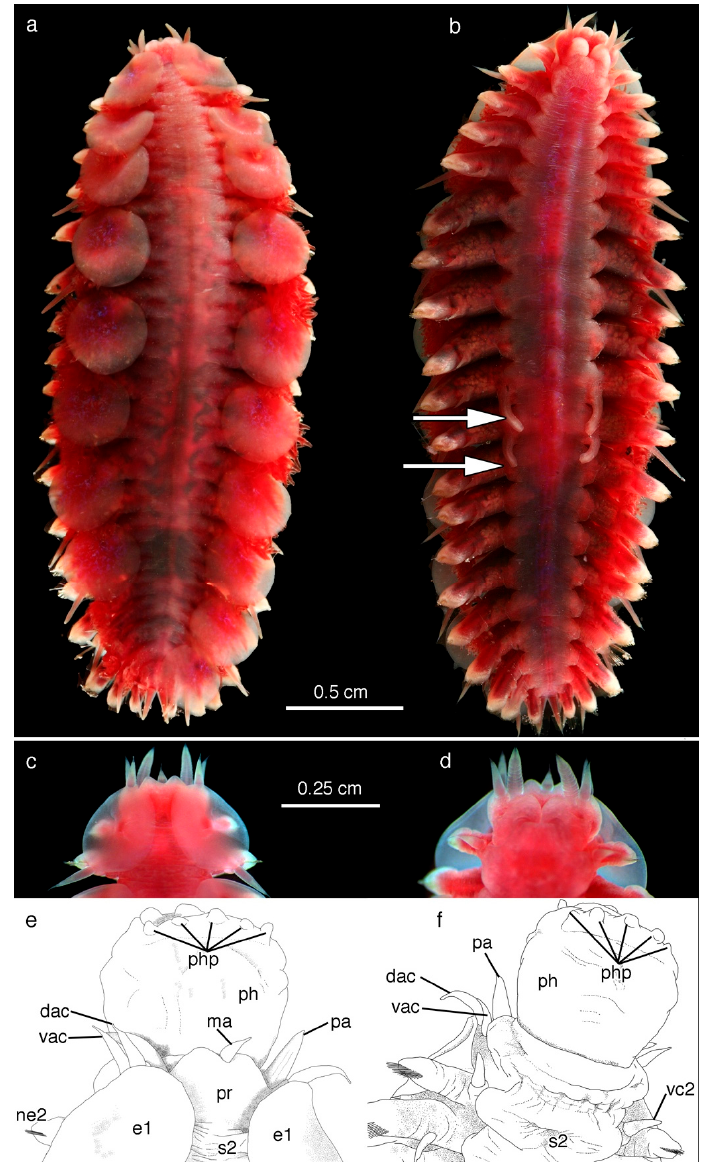
Figure 17. Branchipolynoe tjiasmantoi n. sp. live female holotype (SIO-BIC A5460) and live paratype (SIO-BIC A8511). ( a ). Dorsal view of holotype (SIO-BIC A5460). ( b ). Ventral view of holotype. Arrows indicate elongated ventral papillae of Segments 11 and 12. ( c ). Dorsal view of anterior of paratype head (SIO-BIC A8511). ( d ). Ventral view of anterior of paratype head. ( e ). Drawing of dorsal anterior holotype. ( f ). Drawing of ventral anterior holotype. Abbreviations: pa, palps; ma, median antenna; ph, pharynx; php, pharynx papillae; pr, prostomium; e1, first elytron (attached on segment 2); s2, segment 2; dac, dorsal anterior cirrus; vac, ventral anterior cirrus; vc2, ventral cirrus on segment 2.